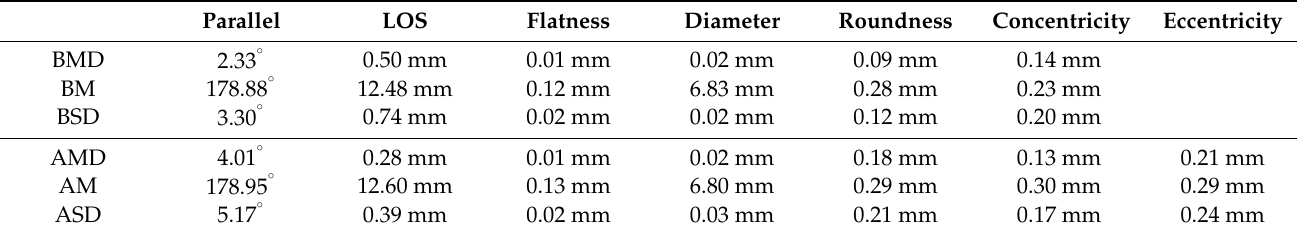
Table 4. Line abnormal nut detection.